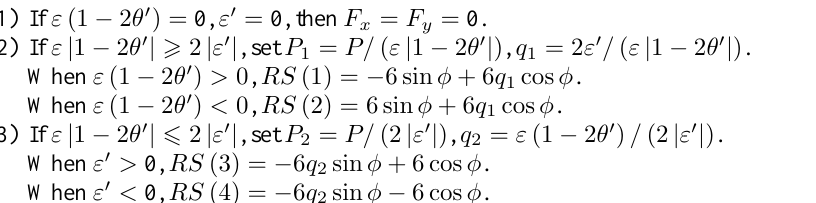
Fig. 2. Balance schematic